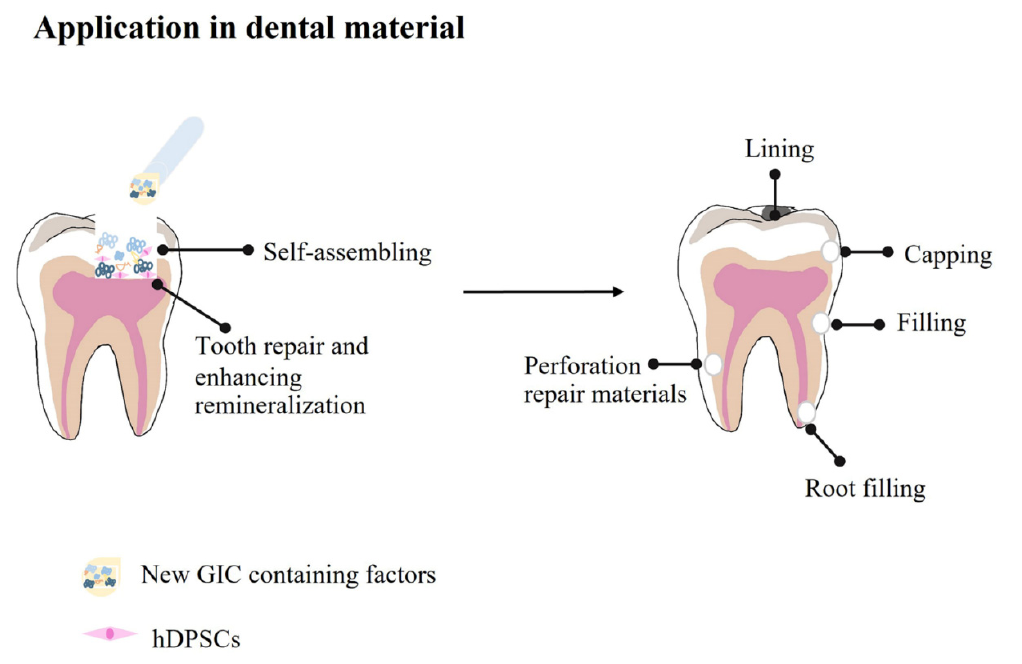
Figure 1. Conceptualization and utilization of new glass ionomer cement in clinical